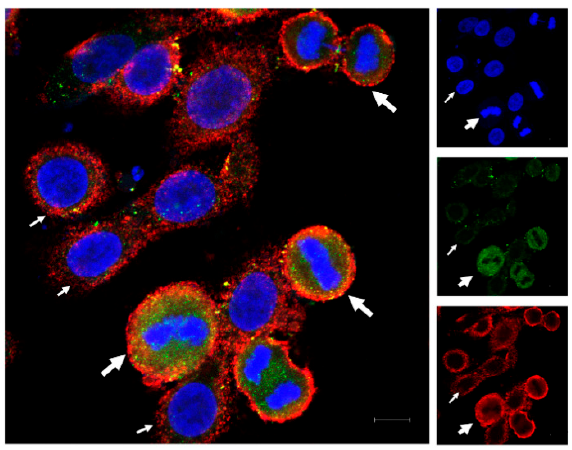
Figure 1. Immunofluorescence for HLA-G and PD-L1 in OVCAR-3 cells. OVCAR-3 cells were cultured in cell chamber and stained for HLA-G (green) and PD-L1 (red) and DAPI (blue) for nucleus. An increased expression of the two proteins (HLA-G and PD-L1) was observed in dividing cells (thick white arrows with dividing nuclear material) compared to non-dividing cells (thin white arrows; scale bar: 10 µm).